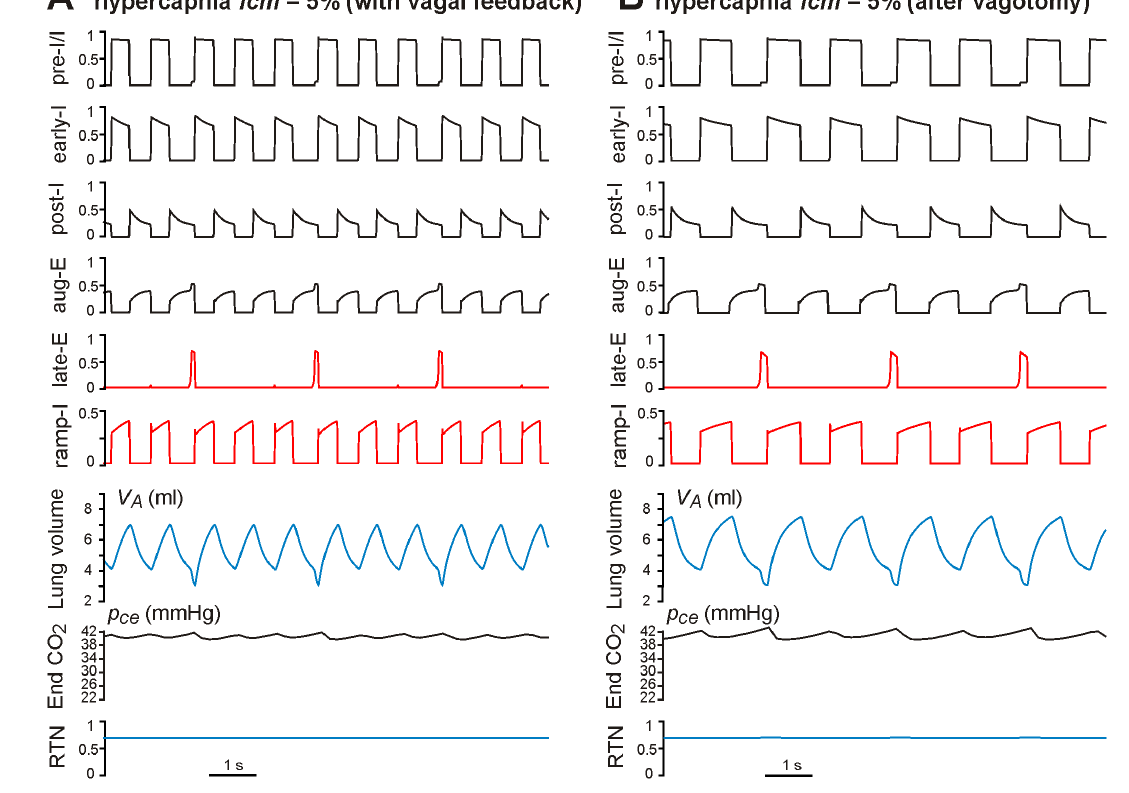
Figure 4. Effects of hypercapnia maintained at f cm =5% in the intact (A) and vagotomized (B) models. f cm is CO 2 content in the mouth. In both cases, hypercapnia evoked increases in RTN drive (bottom traces in A and B ). The applied hypercapnia increased the RTN drive to the late-E neuron evoking late-E discharges with the ratio 1:3 to the ramp-I discharges in the vagus intact model (late-E trace in A ) and the ratio 1:2 in the vagotomized model (late-E trace in B ). Each late-E pulse actuates the abdominal pump, reducing the base level of lung volume (see V A traces in A and B ).